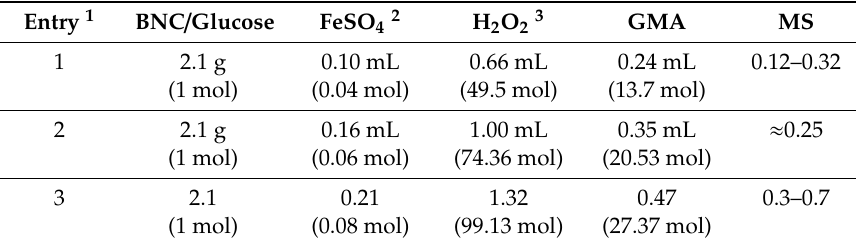
Table 2. Fenton-type GMA grafting in function of the reagent